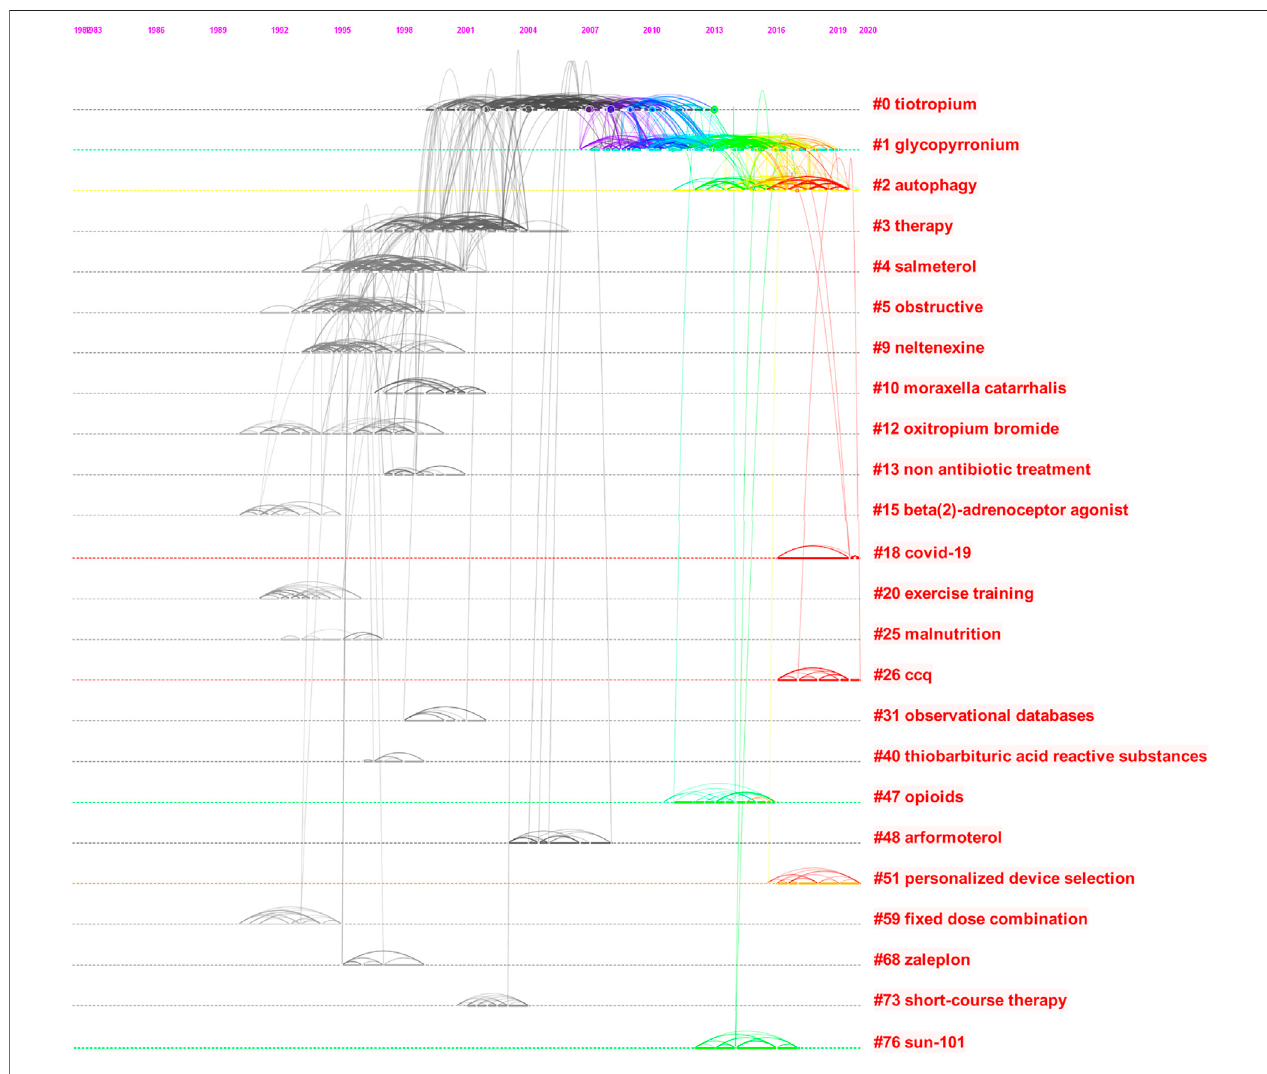
FIGURE 9 | Co-citation analysis of COPD drugs-related studies that were published from 1980 to 2021.